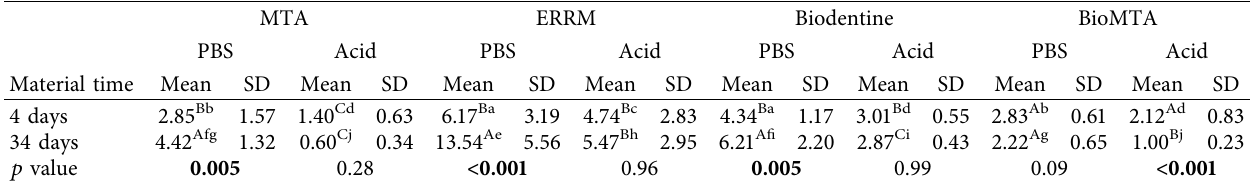
Table 1: The dislocation resistance (MPa) regarding storage time and media is given in means ± SD.